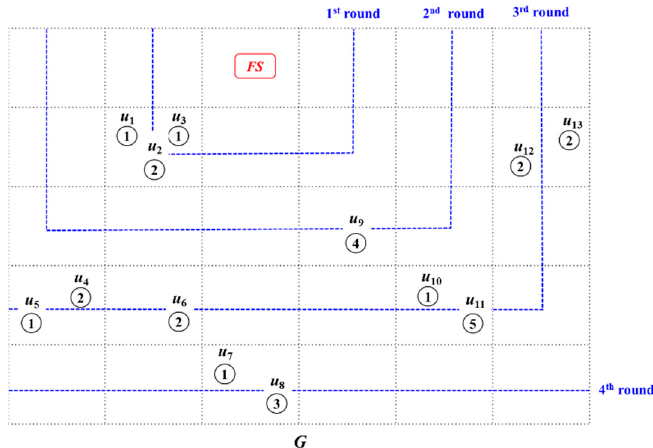
Figure 1. An example of node distribution over a grid.